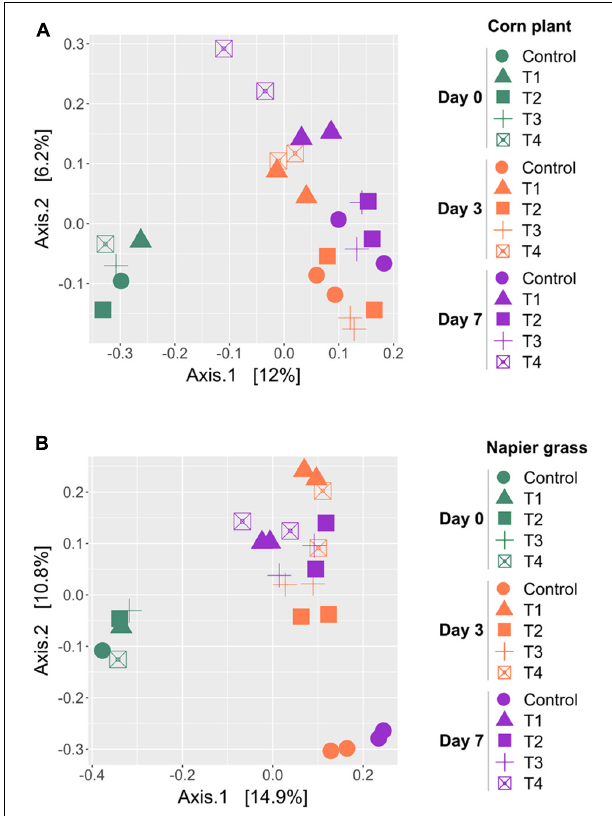
FIGURE 3 | Principal coordinates analysis (PCoA) of bacterial community profiles in silages made from whole-plant corns (A) and Napier grasses (B) . The analysis was carried out based on unweighted-UniFrac distance matrix, and individual samples were color-coordinated according to sampling day of the ensiling, in which green represents Day 0 (D0), orange represents Day 3 (D3), and purple represents Day 7 (D7). A control group (circle), and the four groups with potential lactic acid bacteria starter cultures, Lactobacillus plantarum J39 (T1, triangle), L. brevis BCC42336 (T2, square), Pediococcus pentosaceus TBRC7603 (T3, plus sign), and a combination of L. plantarum J39, L. brevis BCC42336, and P. pentosaceus TBRC7603 (T4, opened square) were compared.